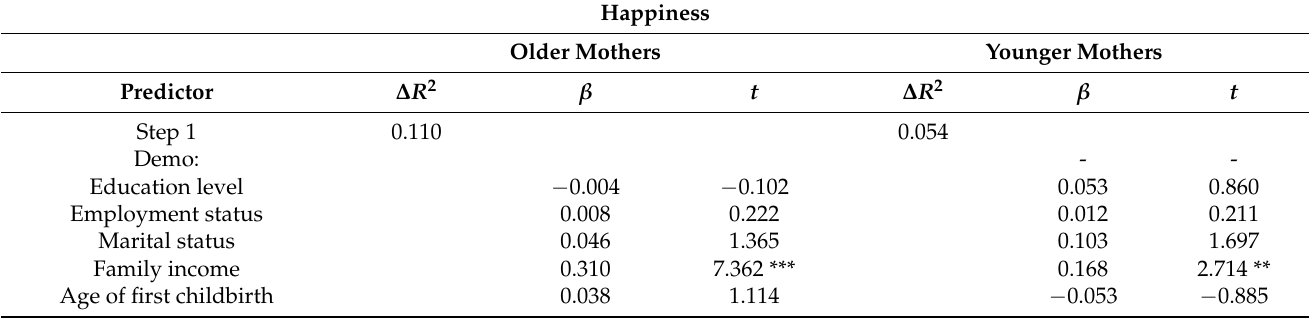
Table 5. Hierarchical regression analyses predicting happiness from presence of meaning in moth- erhood and perceived social support from family among older ( n = 819) and younger mothers ( n =